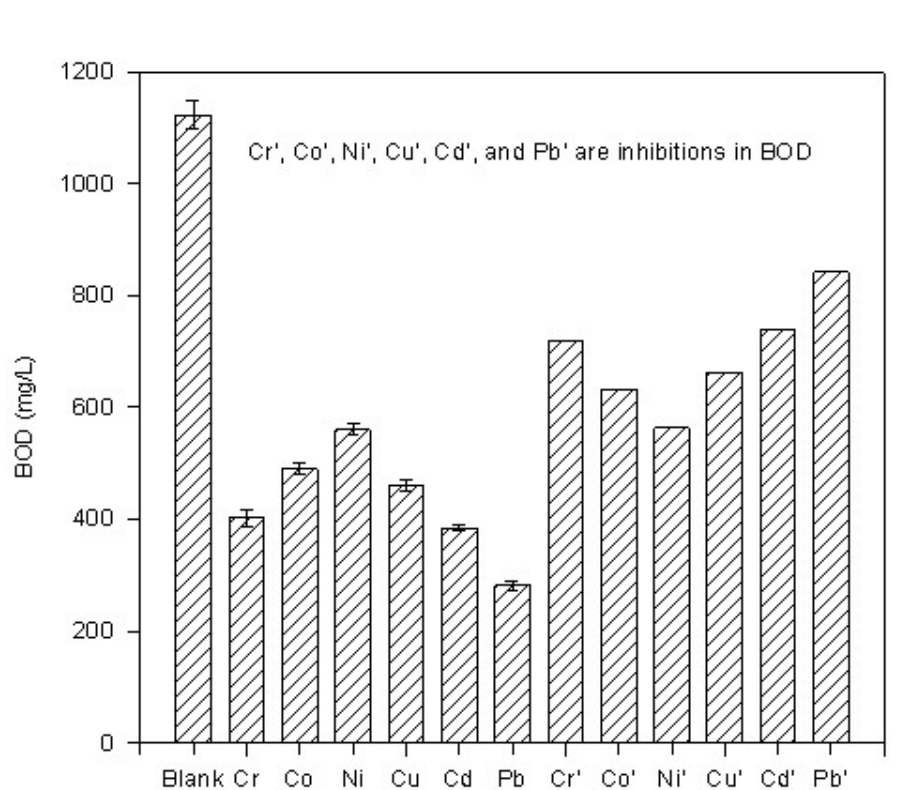
Figure 3 : Histogram of BOD in presence of metal ions at 25 0